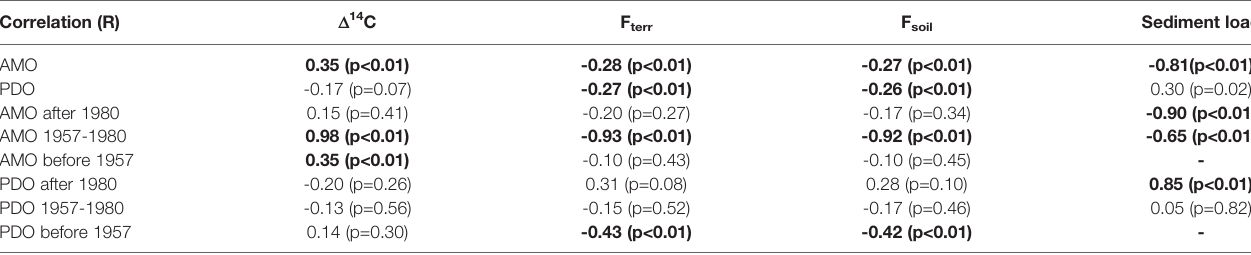
Values in bold indicated signi fi cant correlations